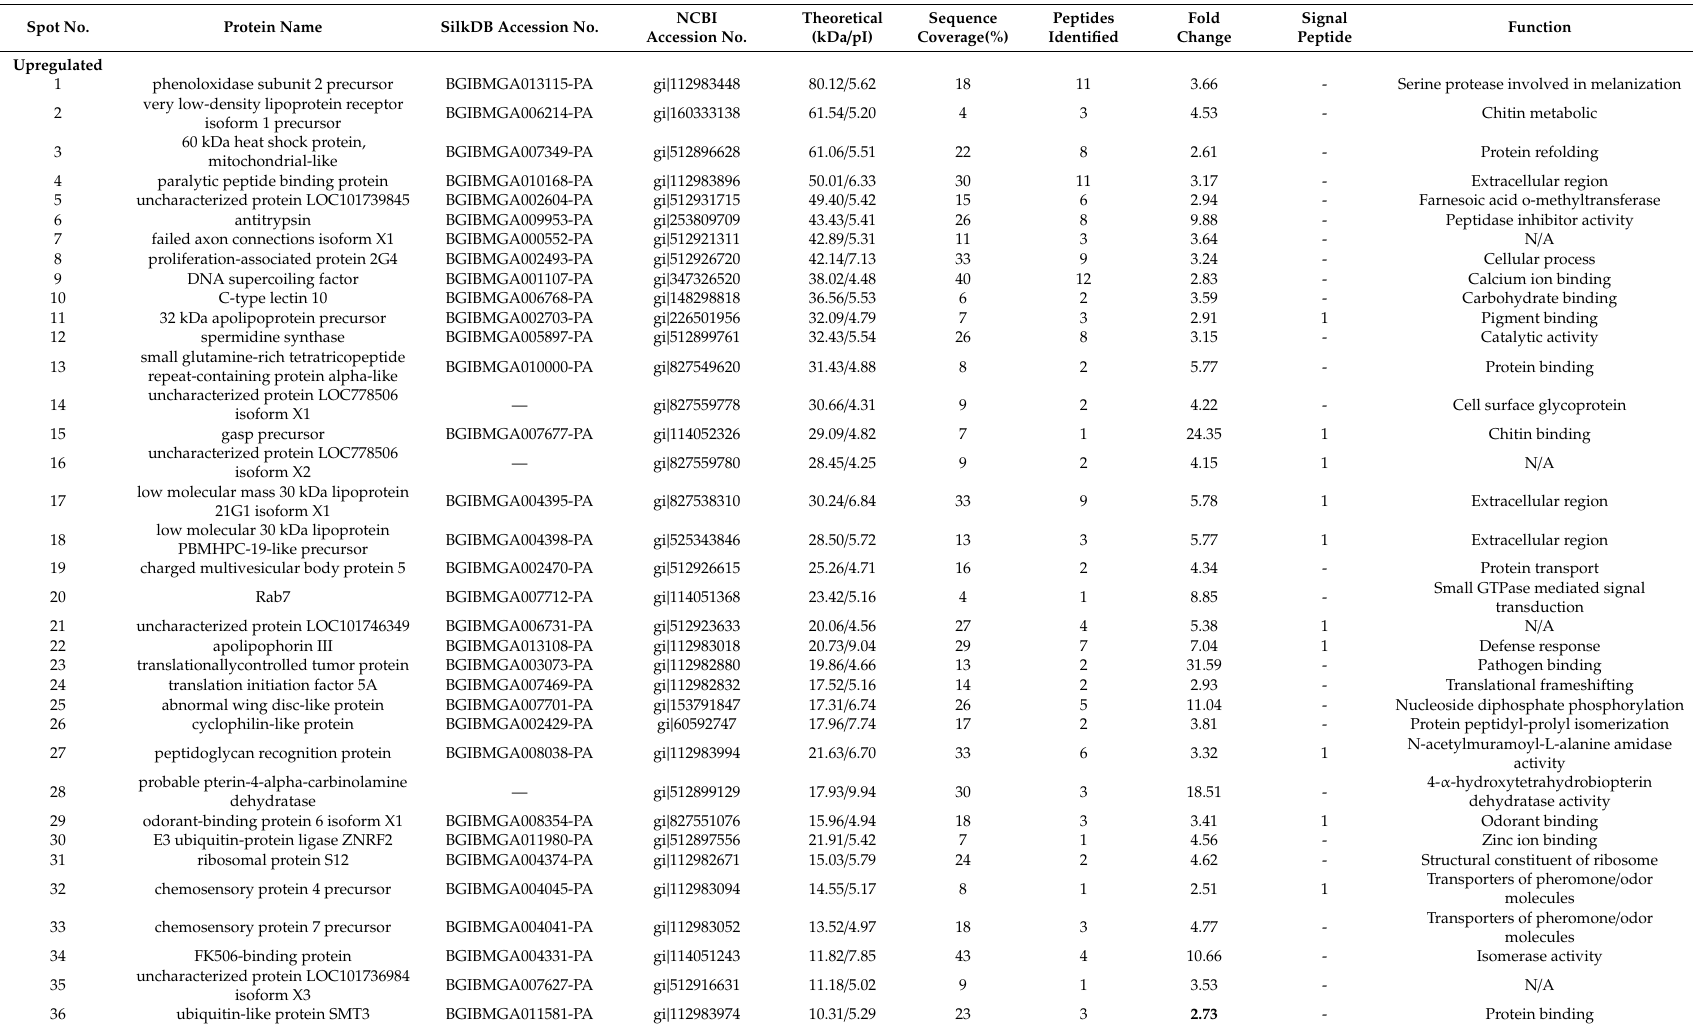
Table 1. Data of the 50 DEPs identified by MALDI-TOF / TOF-MS /